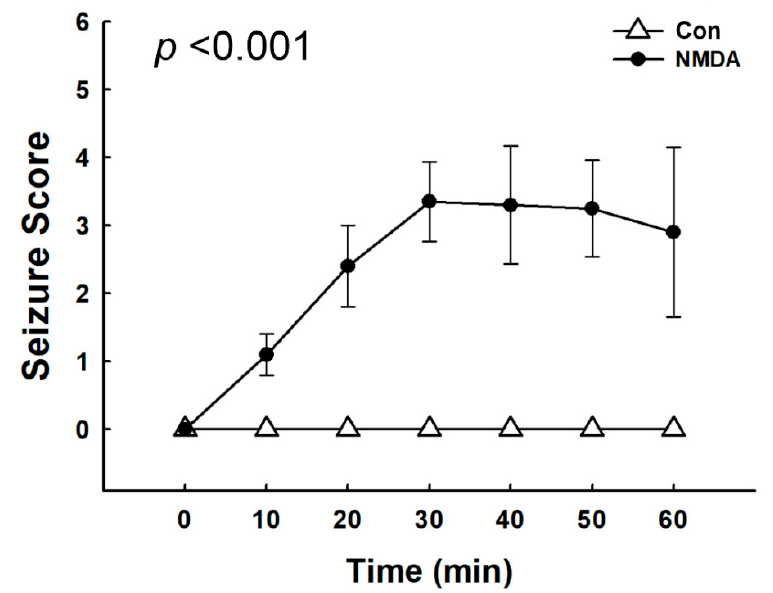
Figure 1. Assessment of the seizure severity in N-methyl-D-aspartate (NMDA)-treated rats. Seizures were immediately triggered in rats following NMDA treatment (75 mg/kg). The scores of seizure severity were assessed every 10 min based on a modified Racine’s scale. The severity of seizures was increased time-dependently. Seizure score: 0 = normal; 1 = motionless; 2 = tail stiffness; 3 = lordotic posture and whip-like tail; 4 = forelimb clonus with rearing and falling, body twist; and 5 = generalized tonic–clonic activity.